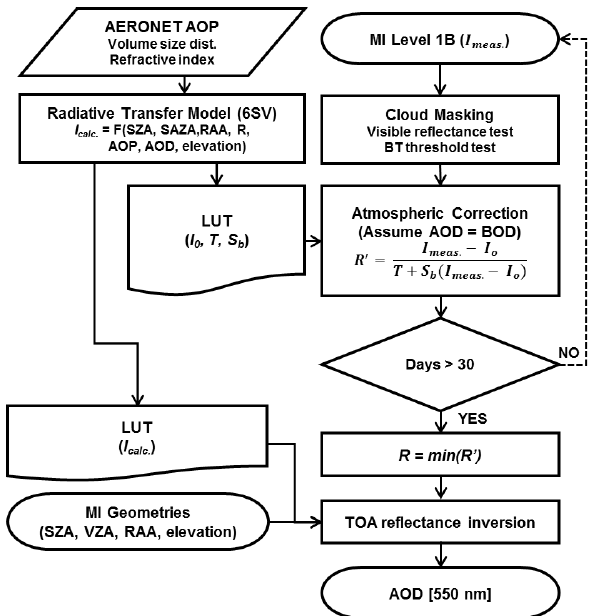
Figure 3. Flowchart of a single-channel algorithm for AOD re- trieval, adapted from Kim et al. (2014). I meas and I calc repre- sent measured and calculated TOA reflectance, respectively. I o means atmospheric reflectance including the Rayleigh scattering and aerosol effect, S b is the hemispheric reflectance, and T is the atmospheric transmittance for the geometry of the sun illumina- tion and satellite viewing. R (cid:48) shows semi-surface reflectance ob- tained by correcting the atmospheric effects from the I meas and the minimum value among the 30-day R (cid:48) is regarded as the surface re- flectance ( R)